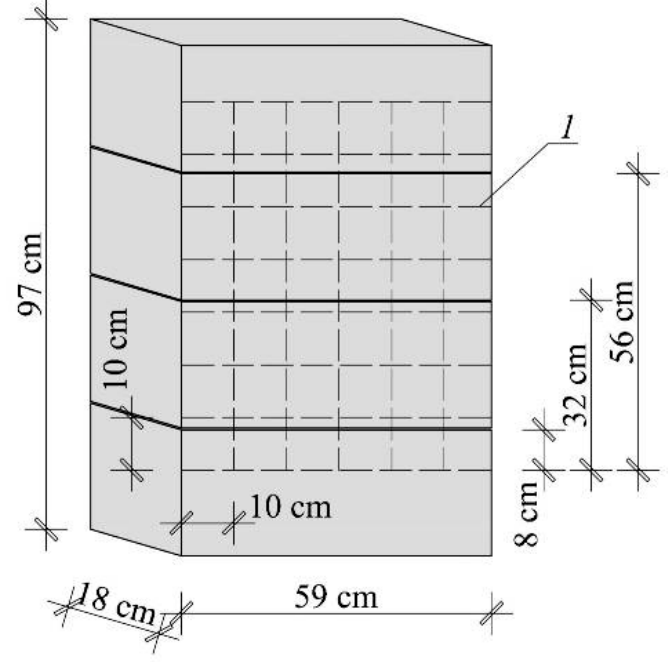
Figure 5. Measuring bases plotted onto masonry test samples, 1 —measuring grid.